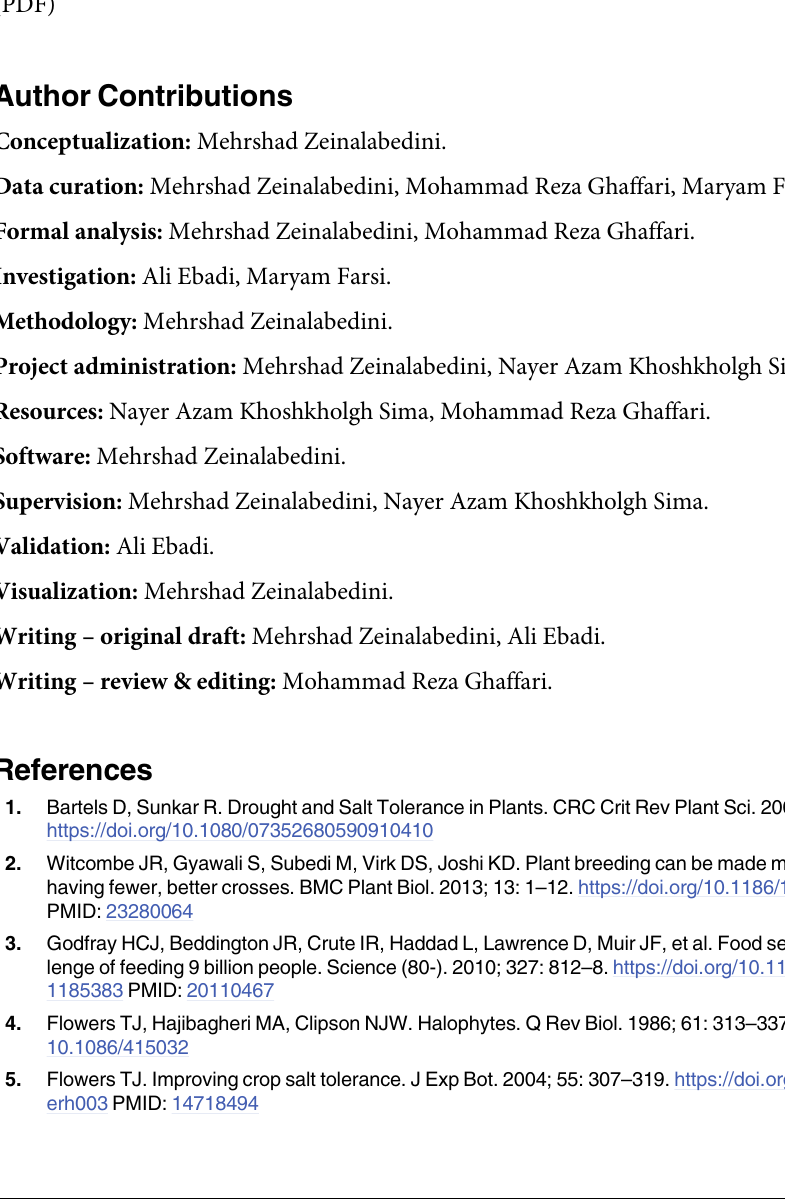
S1 Fig. Taxonomic identifications based on the combination of the identity score value.